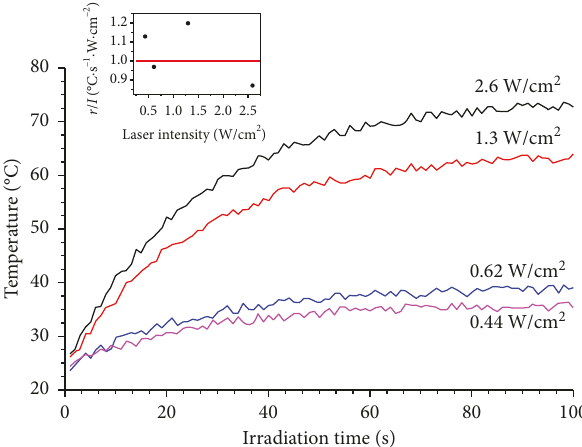
Figure 11: Thermal kinetics at different light intensities obtained irradiating a colloidal sample fabricated with R � 2.74 with an OD of 12 mL − 1 at different light intensities ( I ). Upper inset: initial temperature increases r normalized with the input light intensity I